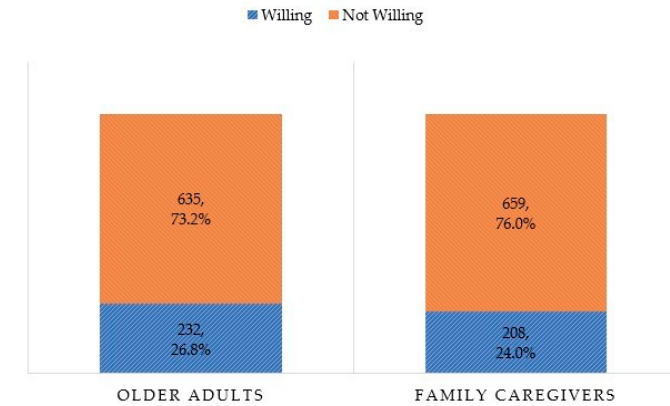
Table 2. The burden of family caregivers, Maehia subdistrict, Chiang Mai, Thailand 2019 .